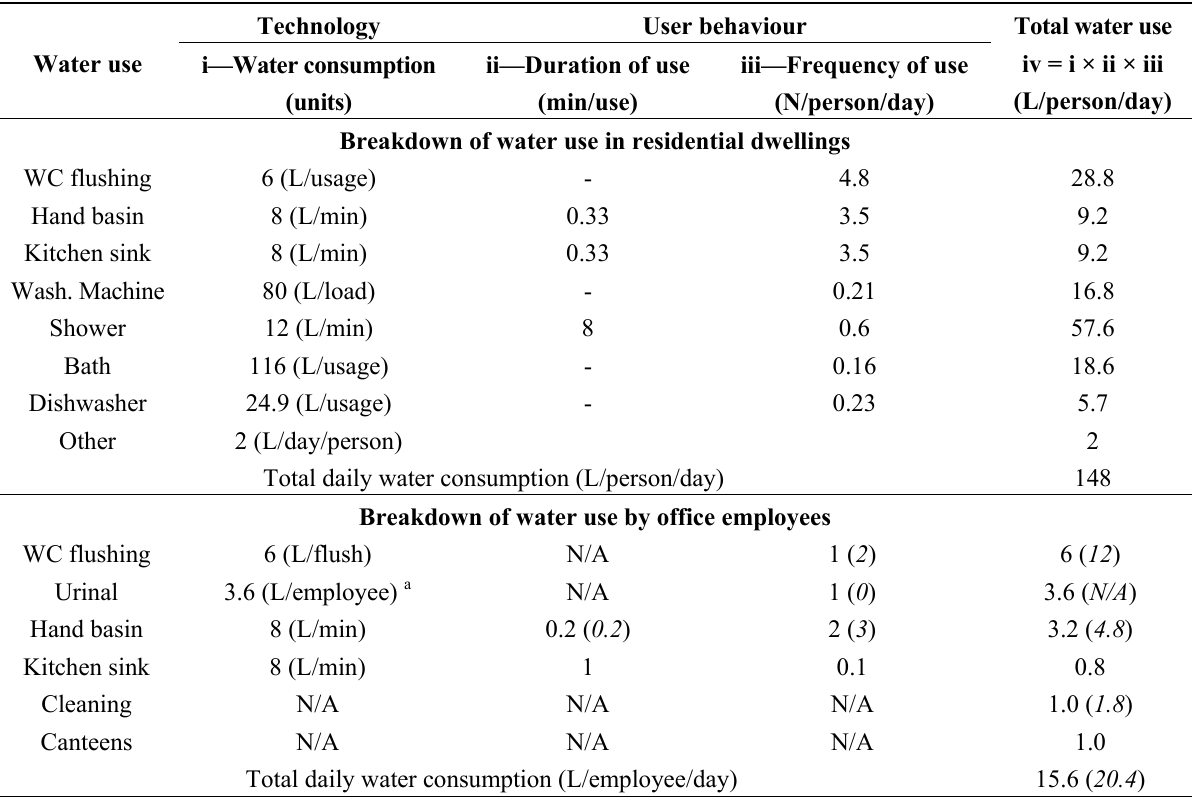
Table 1. Breakdown of water use in residential dwellings and by office employees [9,10]. Italics show where water use by females differs from that of